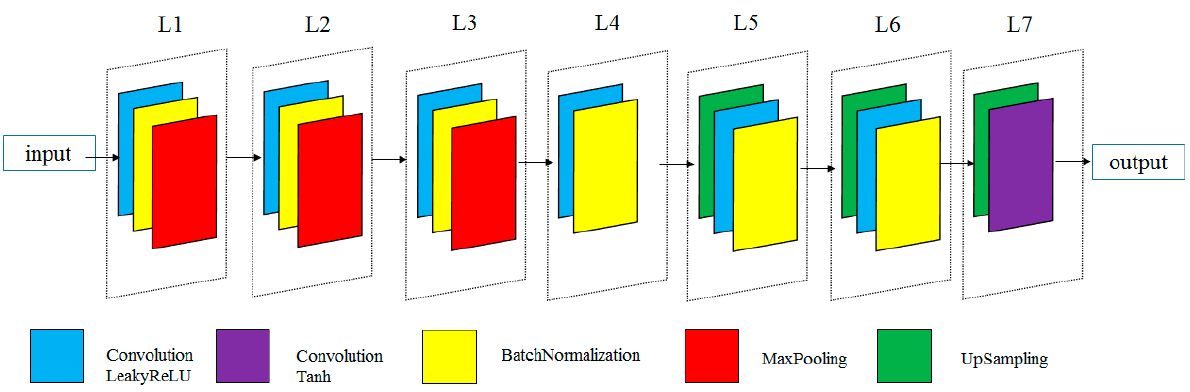
Figure 4. The architecture of our proposed method.